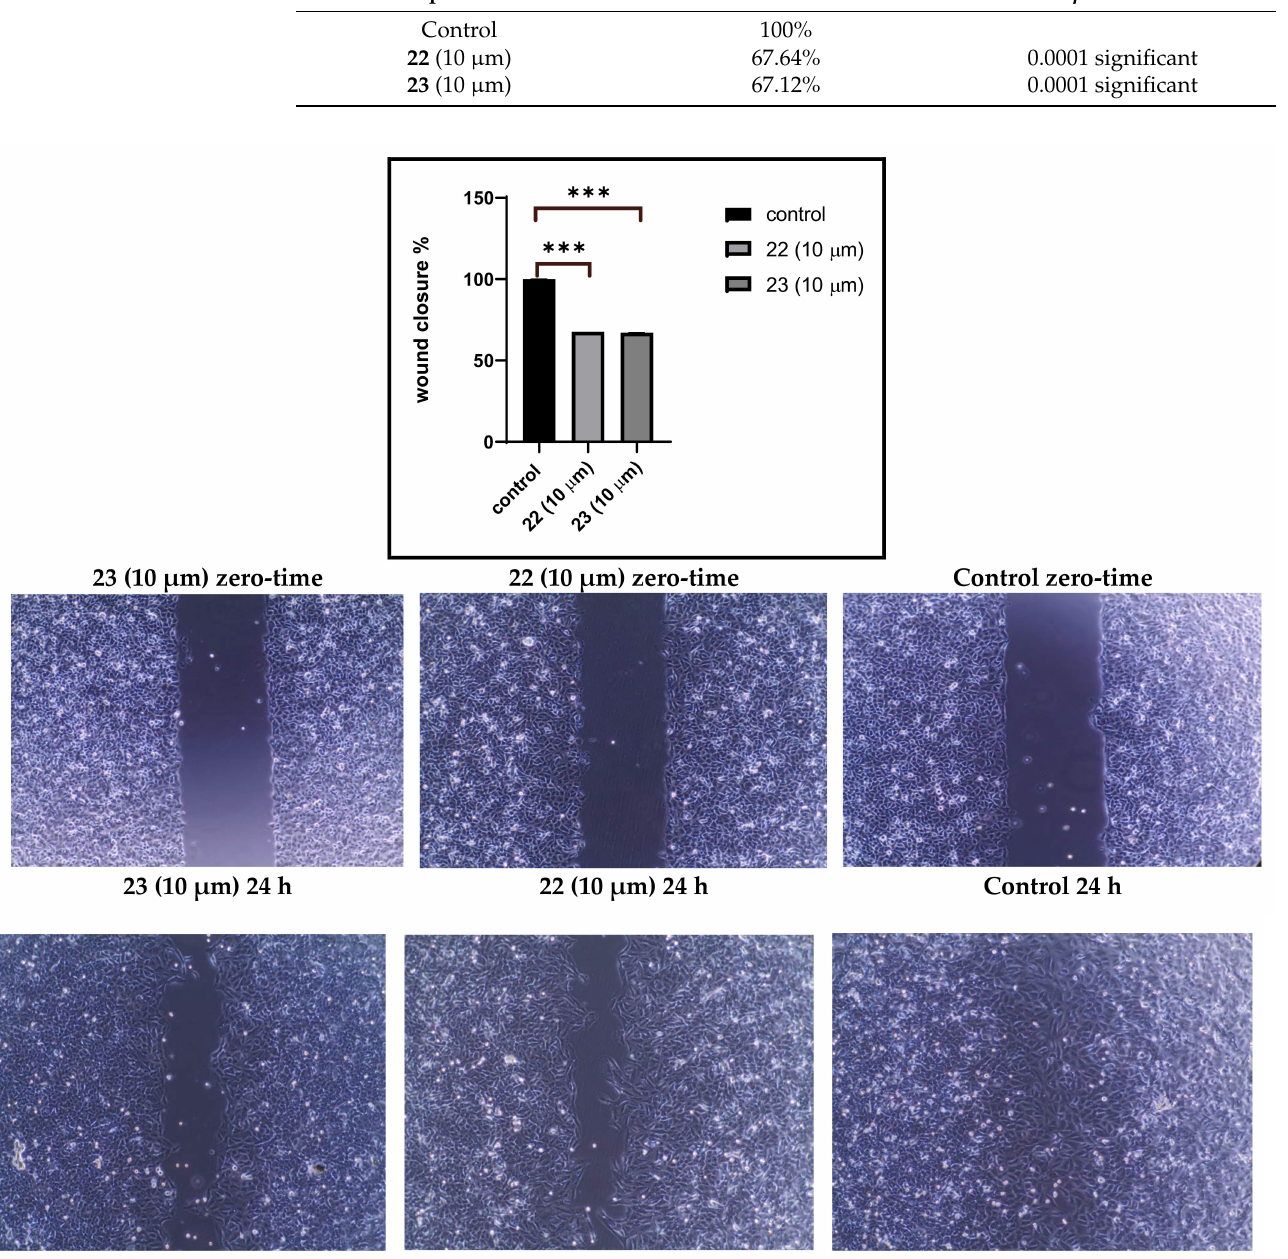
Figure 2. ( A ) Effect of treatment on A549 cell migration column representation. ( B ) Cell 2D migration photos captured by 5.0 Mega Cmos camera at 4 × magnification. Data is presented as percentage wound closure at 24 h of treatment relative to wound width at time